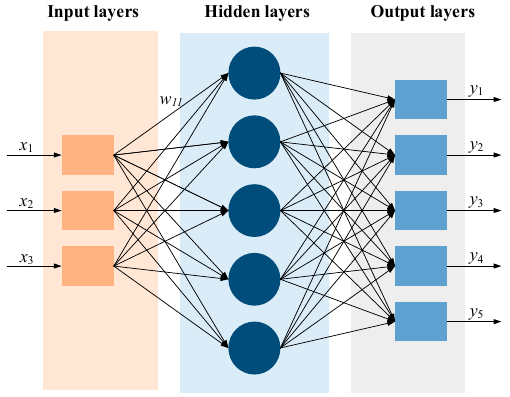
Figure 1. Schematic diagram of traditional neural network.